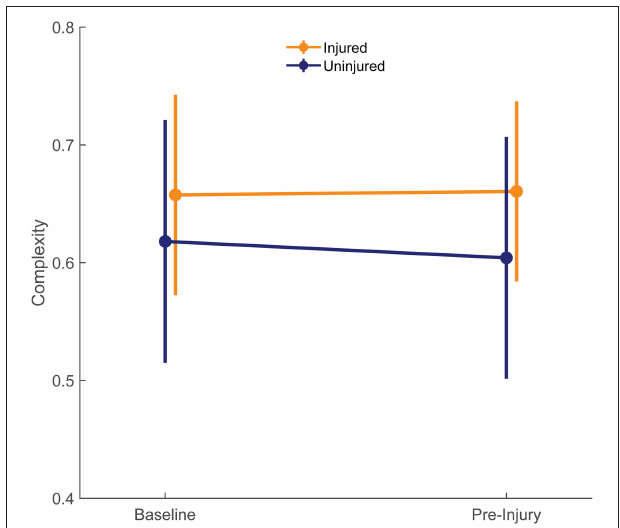
FIGURE 4 | Complexity at baseline of both groups is compared with the last run prior to injury (pre-injury) in injured group. The pre-injury values for the uninjured runners were the median of the corresponding date-matched run of the uninjured control group obtained from the frequency matching procedure (i.e., the medians of each estimate across the 10,000 random pairing replicates). Error bars show ± one standard deviation of the group mean.